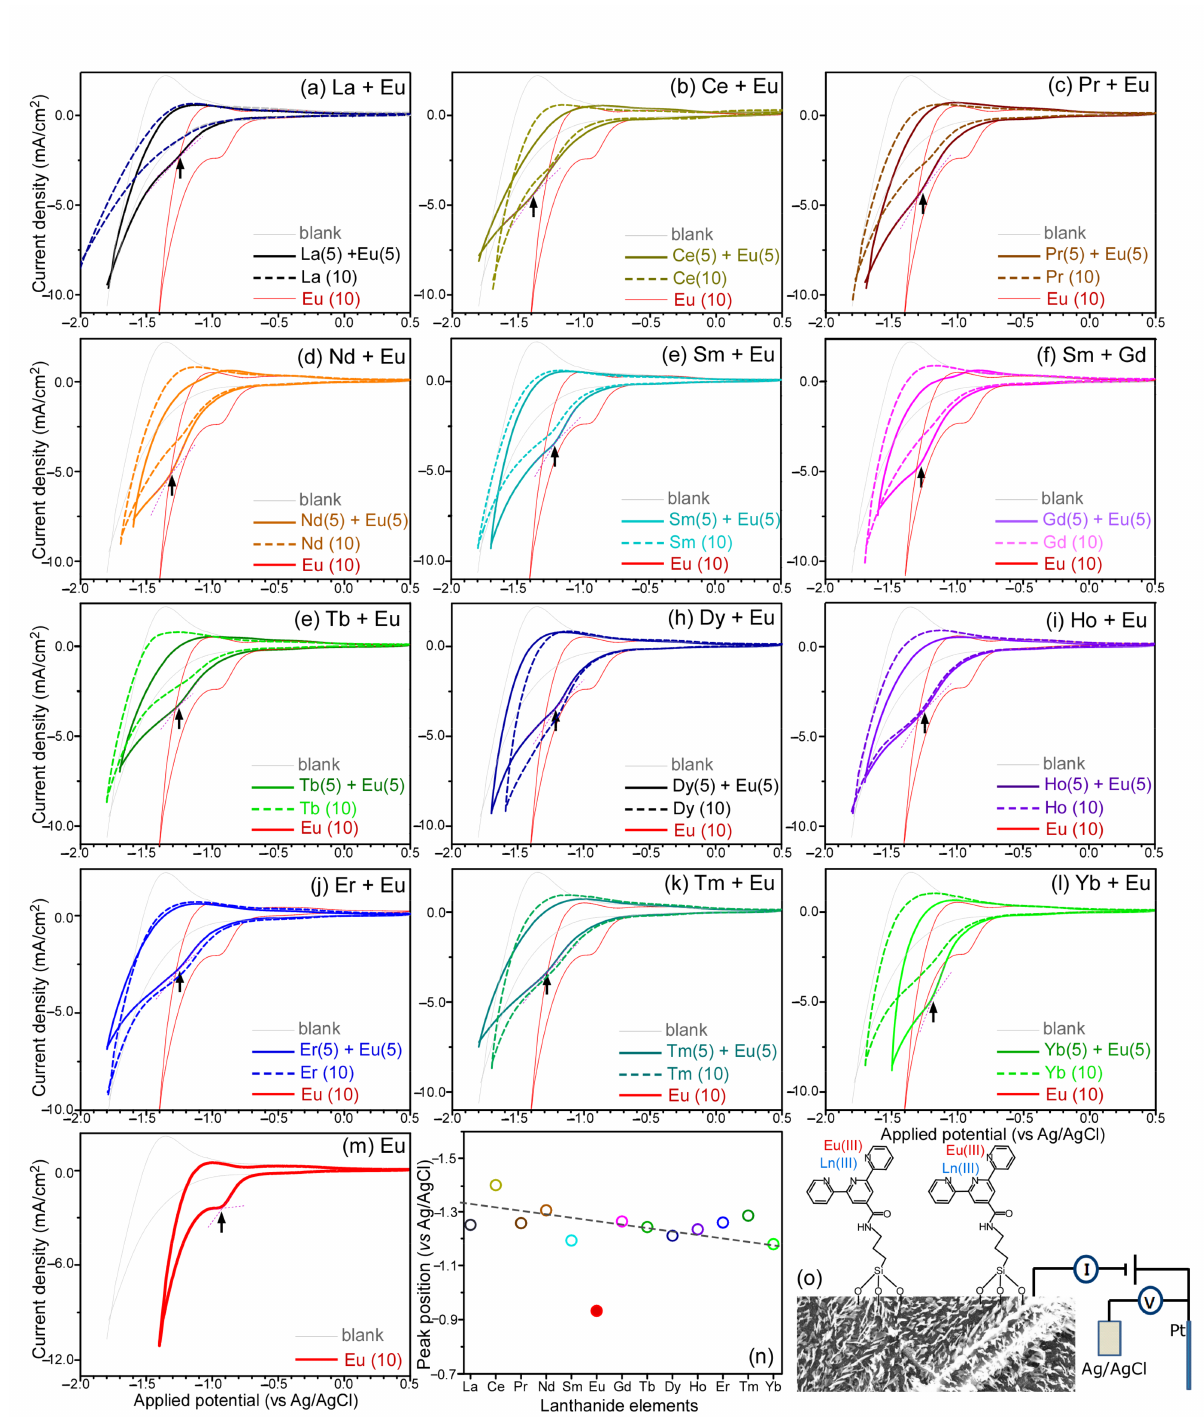
Figure 1. Superimposed cyclic voltammetry profiles ( a – m ) at 0.2 V/s over TiNS-SiTpy electrodes in a blank 0.1 M NaClO 4 (thin gray lines), 5 mM Eu (III) + 5 mM Ln (III)/0.1 M NaClO 4 (thick lines), 10 mM Ln (III)/0.1 M NaClO 4 (broken lines), and 10 mM Eu (III)/0.1 M NaClO 4 (red lines) electrolytes, the new peak positions (V vs. Ag/AgCl) with mixed Ln ions ( n ), and a schematic of the three electrode electrochemical system with a TiNS-SiTpy electrode ( o ). Each arrow indicates the intersection point of two crossing